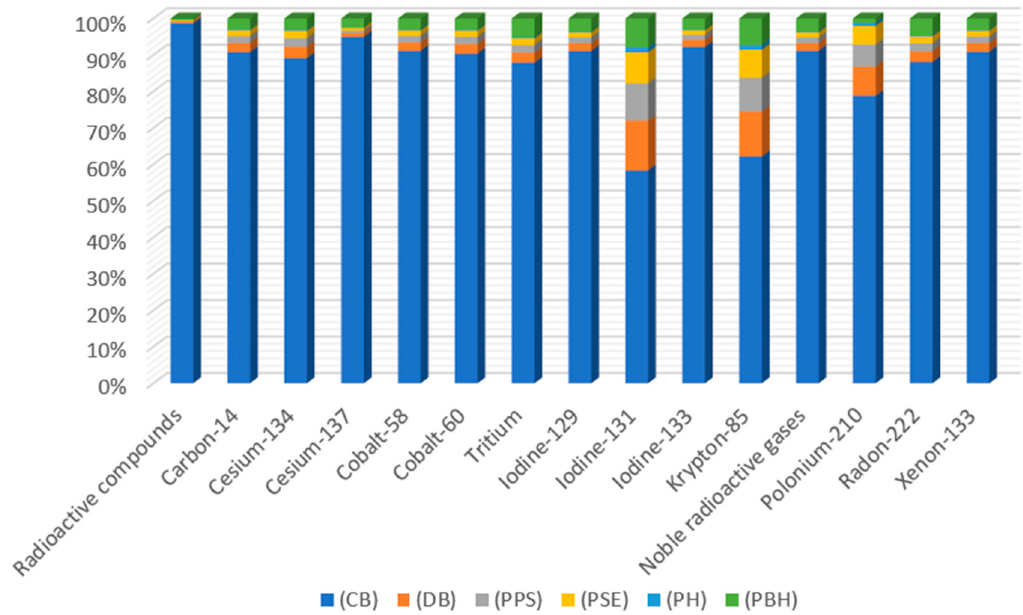
Figure 4. The results of characterization of the amount of ionizing radiation emissions into the air throughout the entire cycle of shaping bottles for beverages made of PLA, which is biodegradable in an industrial composting facility.